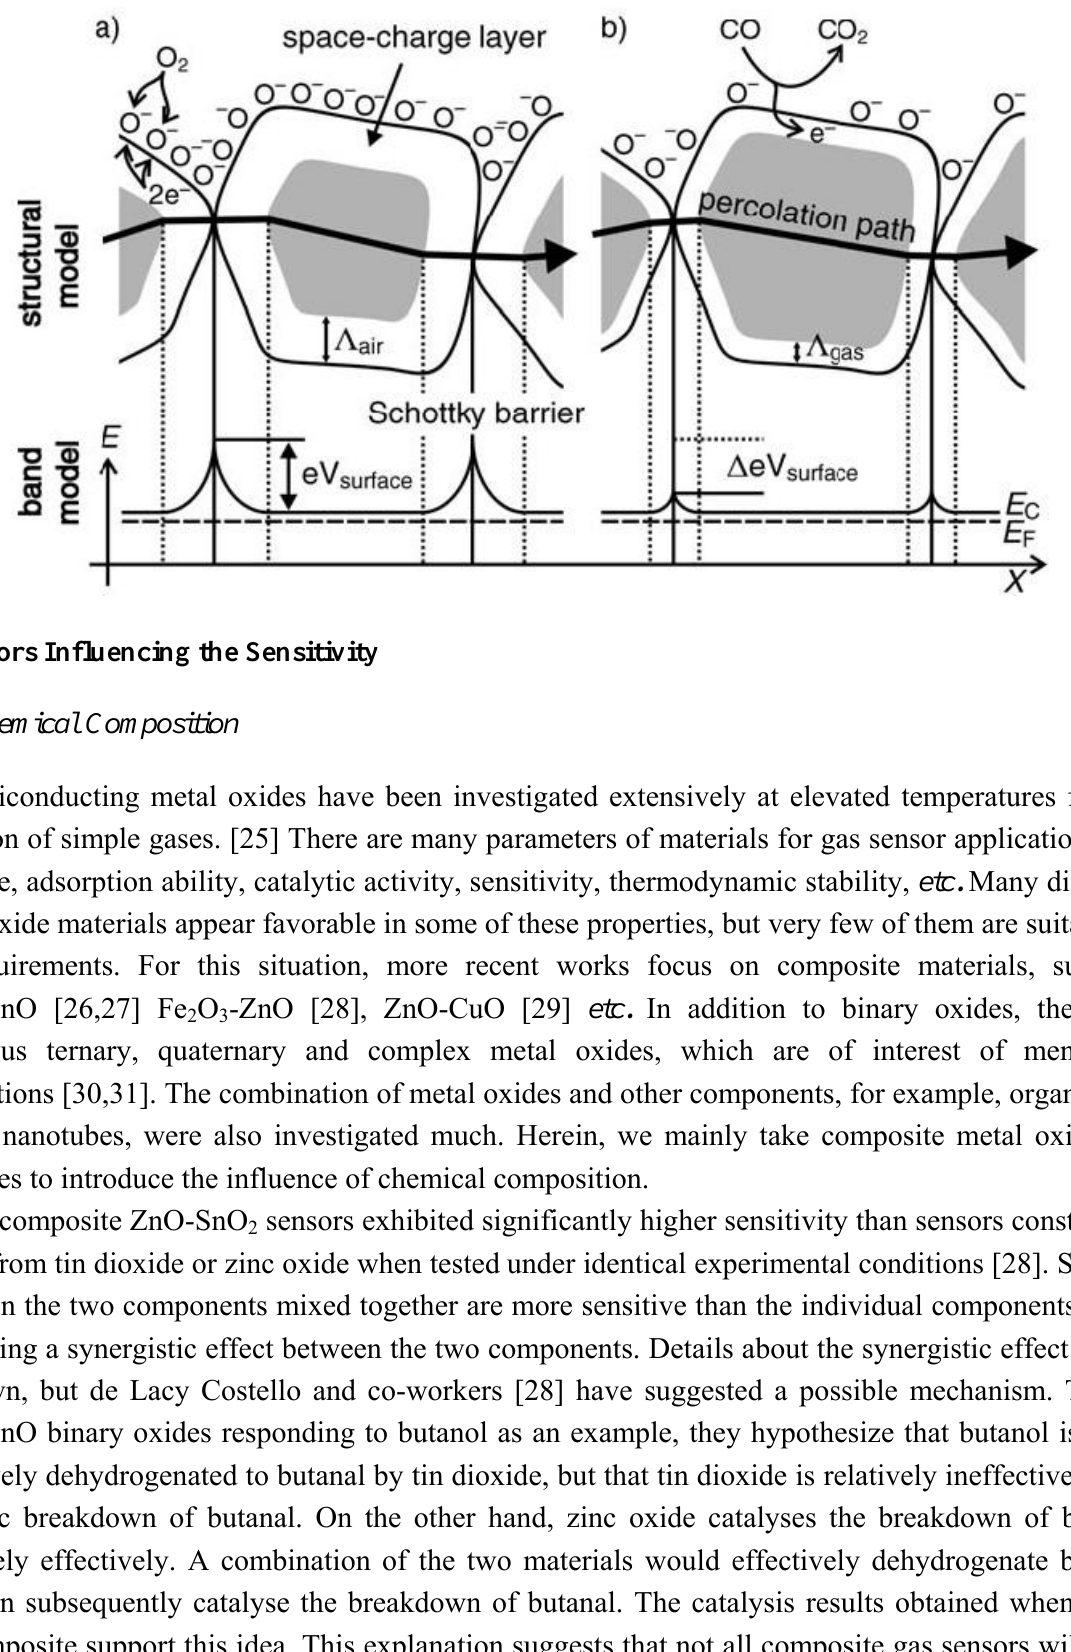
Figure 2. Structural and band models of conductive mechanism upon exposure to reference gas. (a) with or (b) without CO (adapted from